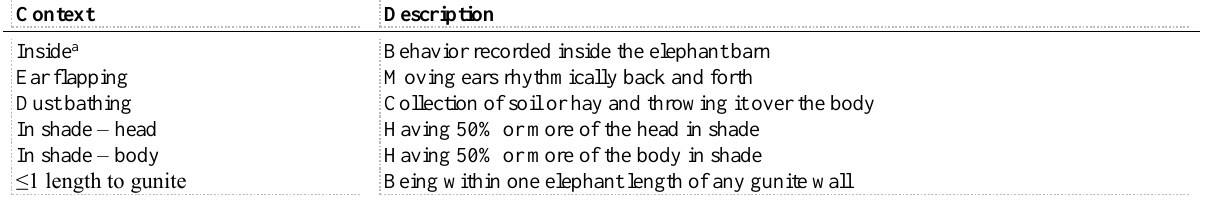
Ethogram Key of Behavioral Contexts Recorded During Diurnal Observation Periods Context